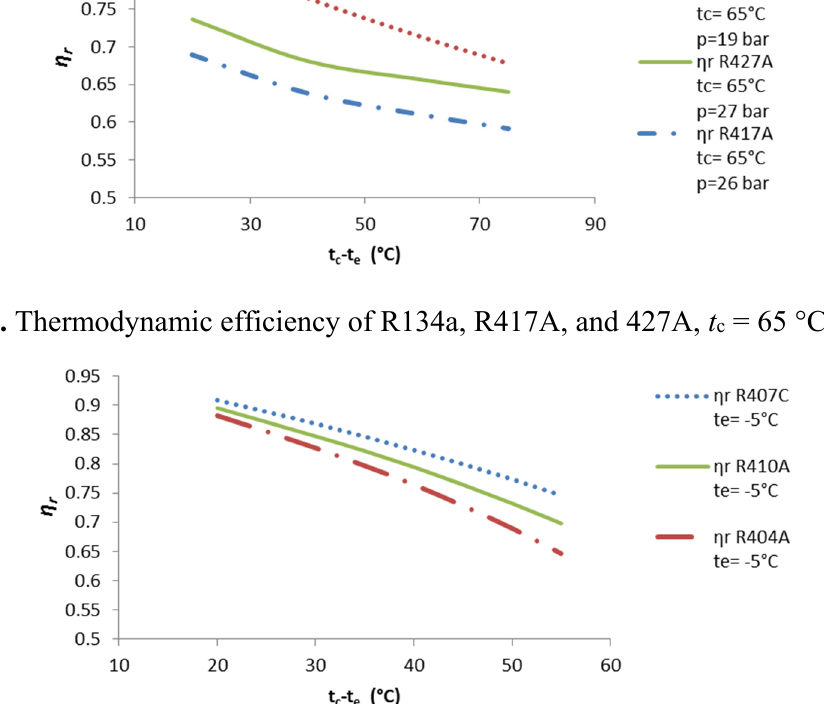
Figure 7. Thermodynamic efficiency of R404A, R407C and R410A, t e = − 5 °C [16].